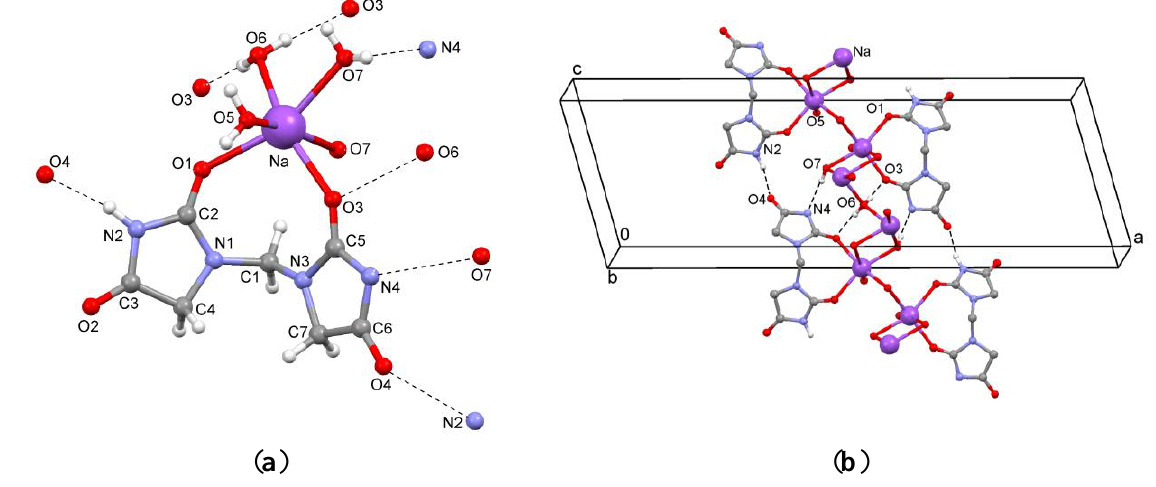
Figure 4. ( a ) Coordination environment of the ion pair; ( b ) Hydrogen bonding of the sodium salt 2a .